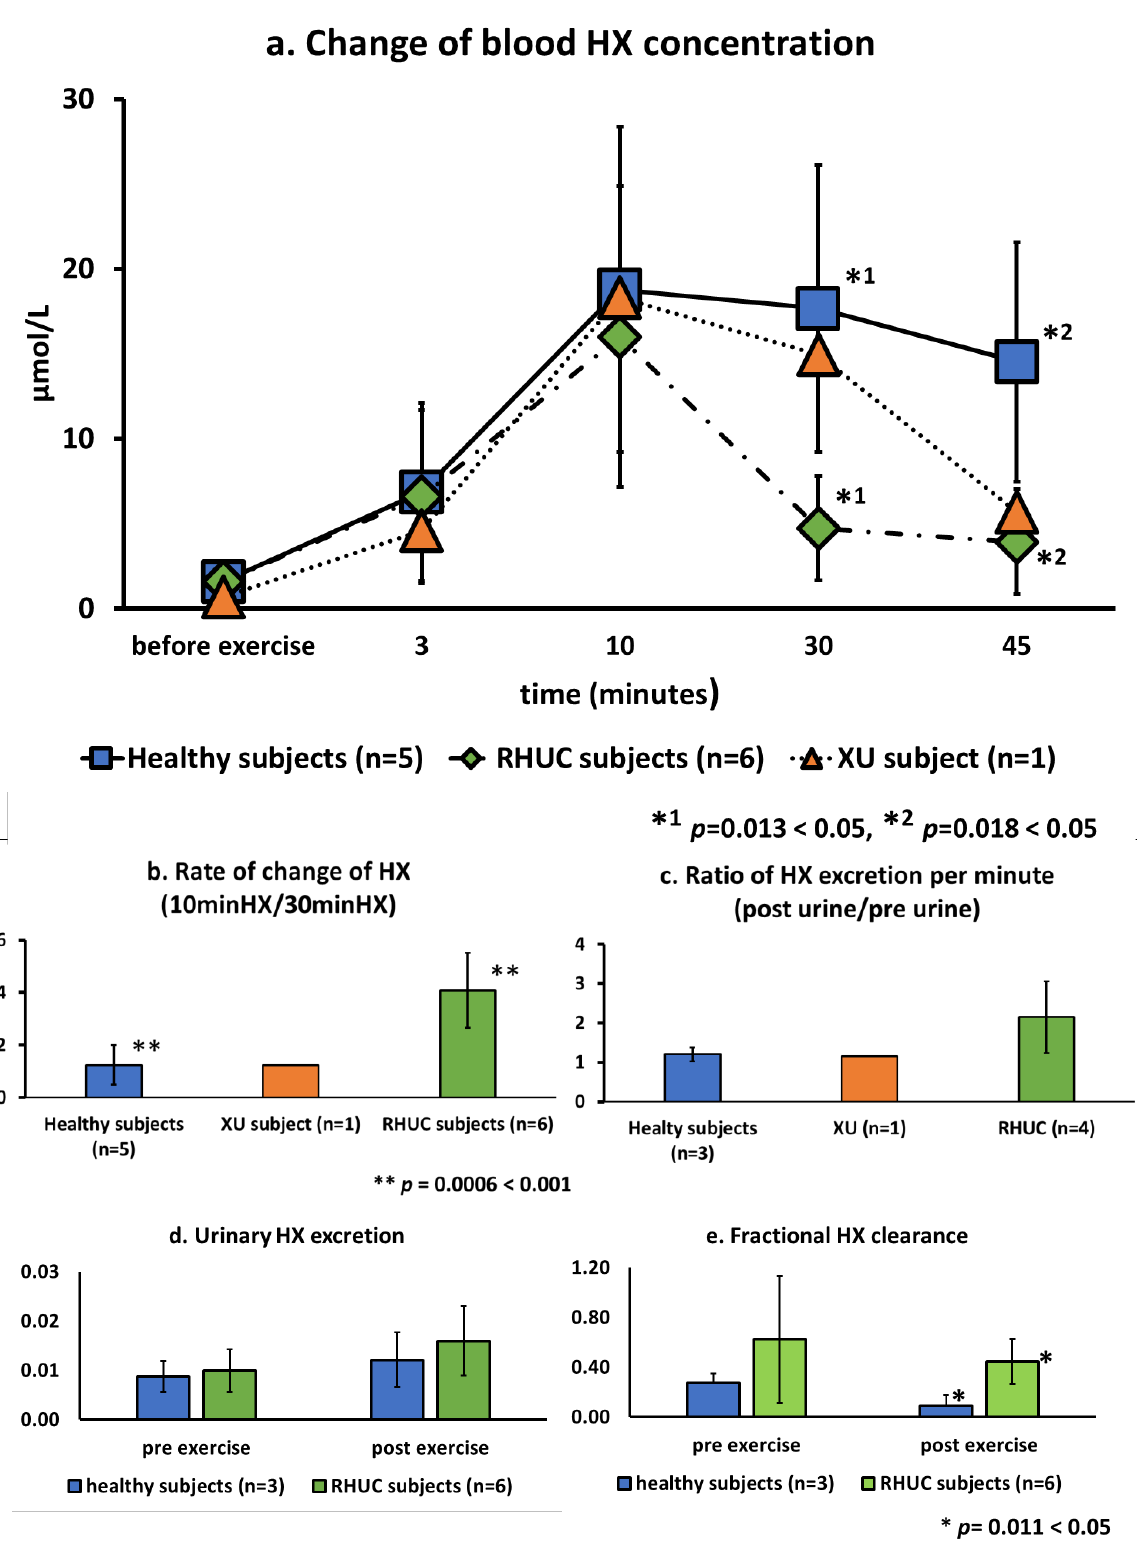
Figure 5. Changes of blood and urine HX concentrations following semi-ischemic forearm exercise test. ( a ): Changes of HX in whole blood of five healthy subjects, one XU subject, and six RHUC subjects after exercise. ( b ): The ratio of blood HX concentration at 10 min of maximum value to 30 min value was taken to show the rate of change of blood HX. ( c ): The ratio of the amount of HX in